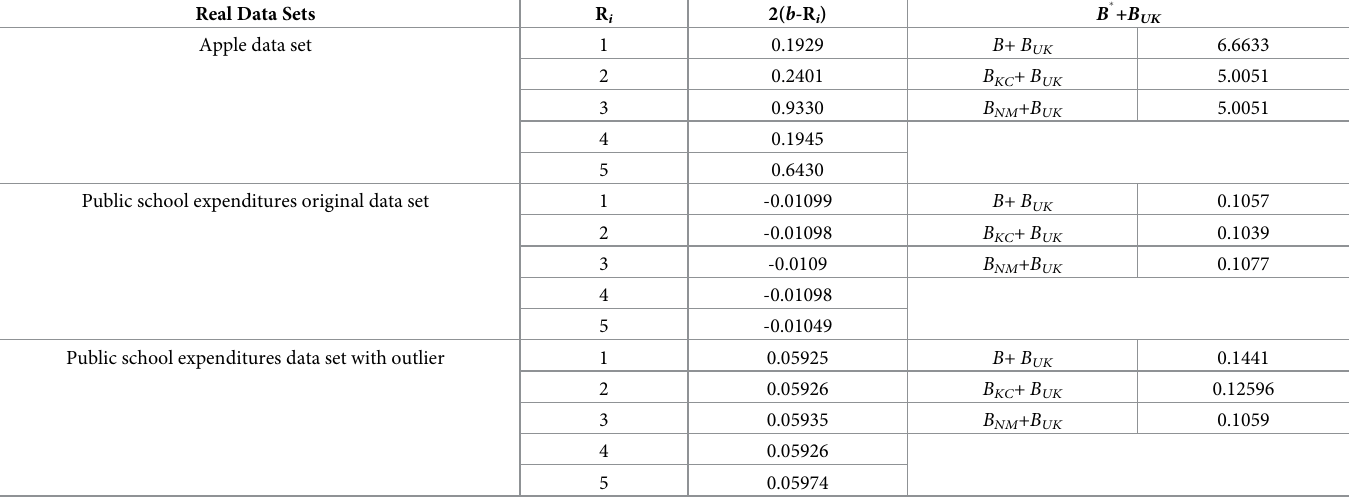
Table 5. Control of condition II for efficiency of the proposed estimator. Real Data Sets